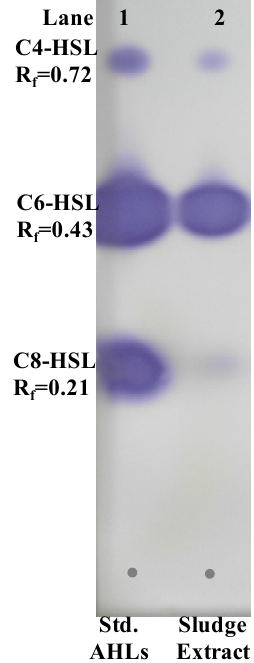
from activated sludge. Lane 1: Standard AHLs (0.5 µg/µL); C4-HSL, C6-HSL and C8-HSL. Lane 2: Extract of the activated sludge (20 µL). Tentative identification of the sludge extracted AHLs based on migration of standards, is